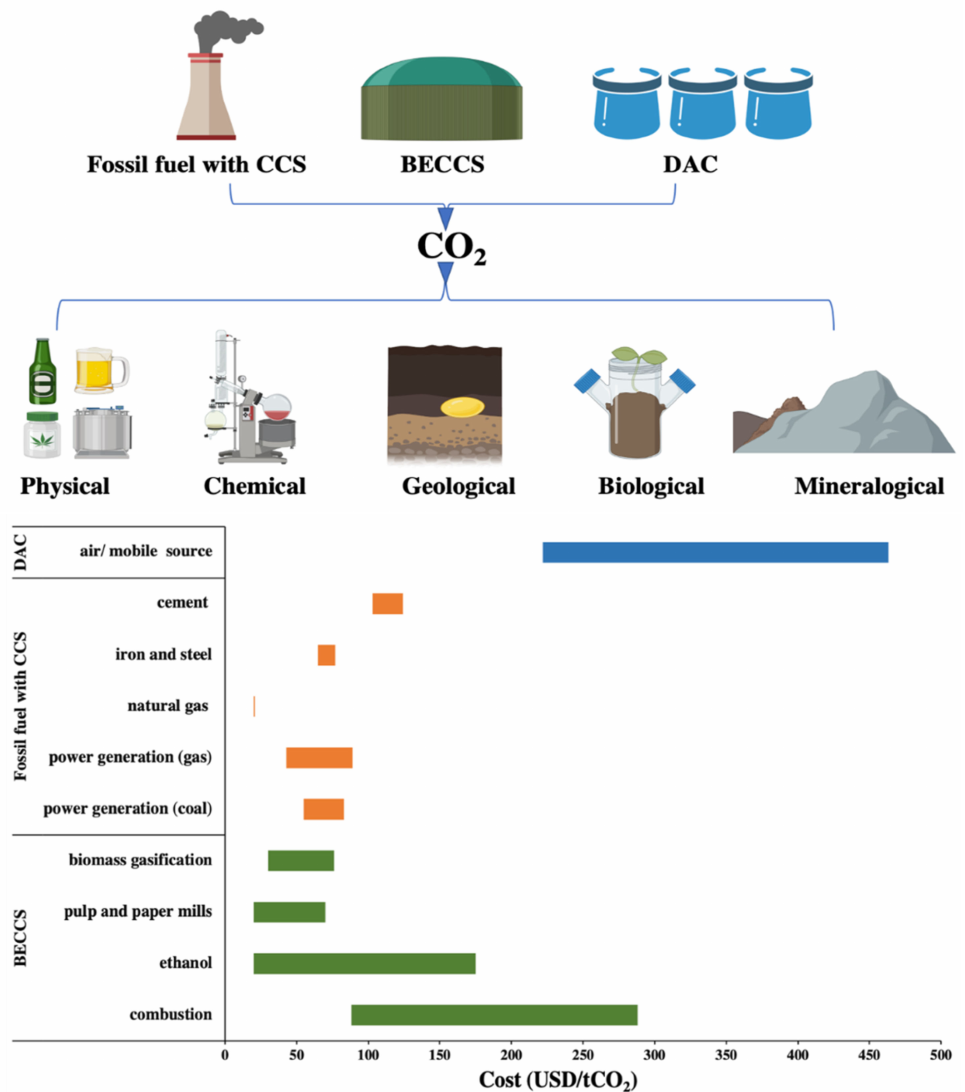
Figure 7. The capture and utilization of CO 2 in different ways and their cost range. Abbreviations: CCS, carbon capture and storage; BECCS, bioenergy with carbon capture and storage; DAC, direct air capture [82,83]. China has made great progress in the last decade in terms of CCUS